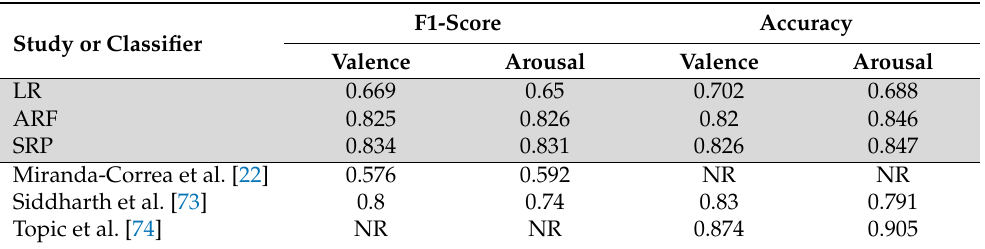
Table 3. Comparison of mean F1-Scores and accuracy of Valence and Arousal recognition on Dataset I. Gray represents the results from this paper. NR stands for not reported.